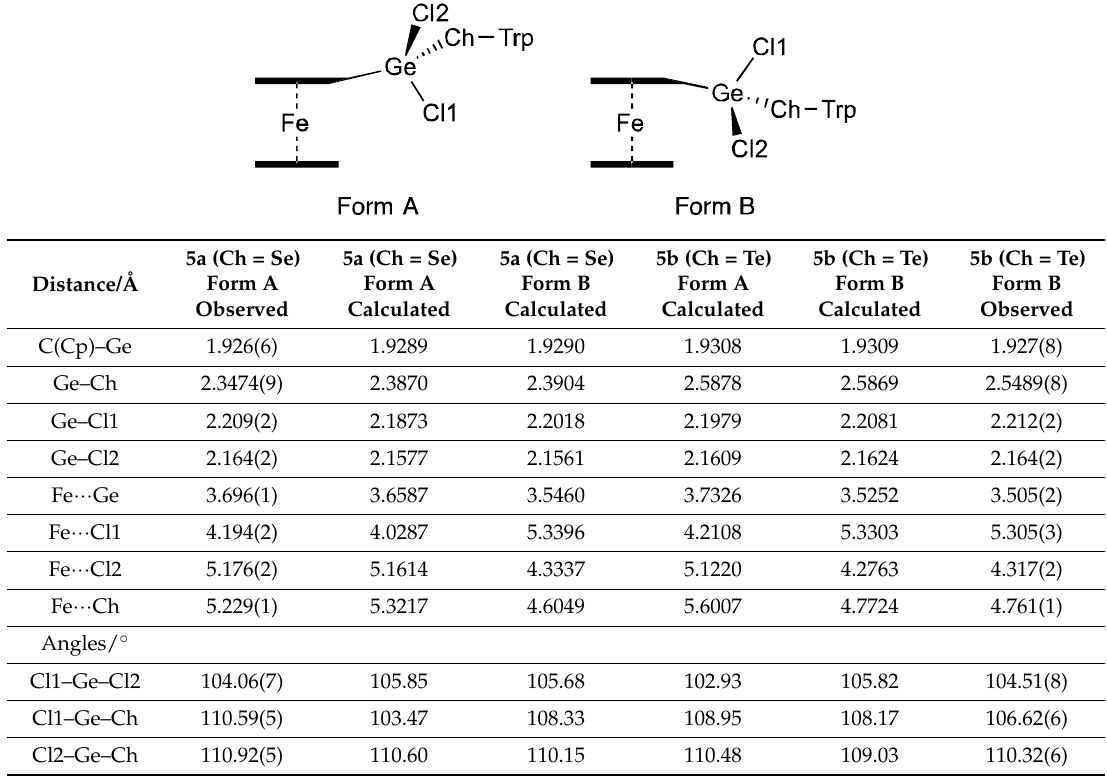
Table 1. Selected structural parameters for 5a-Form A and 5b-Form B (observed: XRD analysis) together with the corresponding theoretical (calculated) values for 5a-Form A , 5a-Form B , 5b-Form A , and 5b-Form B that were optimized at the M062x/6-311G(3d) (Ge, Cl, Fe)/ 6-31G(d) (C, H)/ SDD (Se, Te) level of theory.